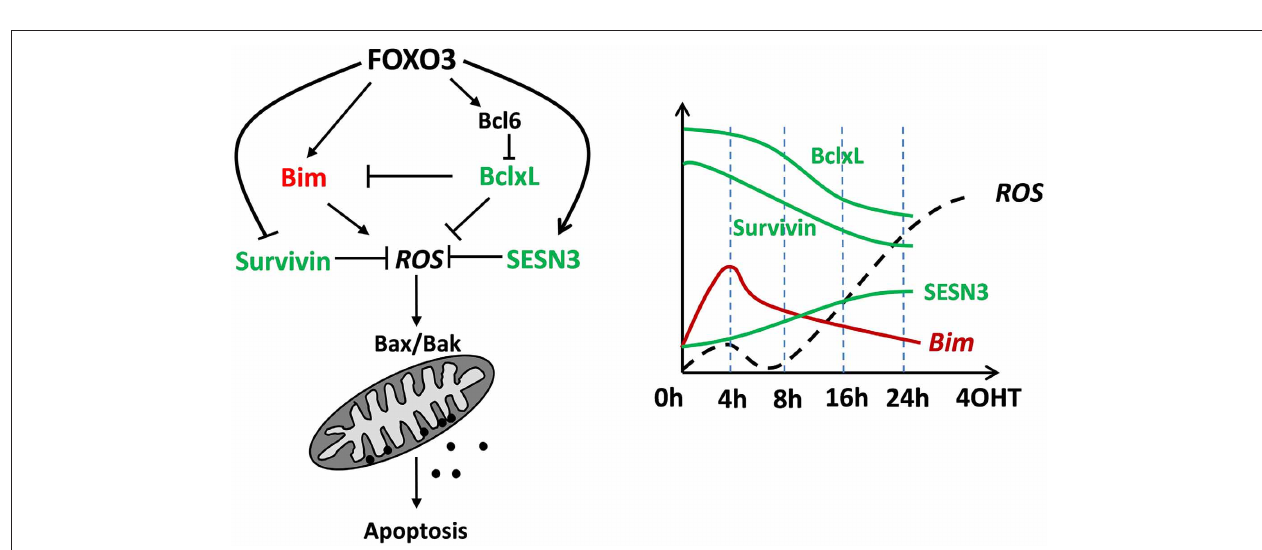
FIGURE 4 | A conceptional view on how FOXO3 regulates mitochondrial ROS and apoptotic cell death in neuronal cells and neuroblastoma tumor cells. Transitory induction of pro-apoptotic Bim by FOXO3 constitutes a first mitochondria-damaging signal that triggers the primary ROS peak at 4h. In parallel the ROS-detoxifying SESN3 accumulates and critically regulates decay of the ROS after 4–6h. Bim-neutralizing BclxL and Survivin are both repressed by FOXO3, thereby lowering the ability of the cell to cope